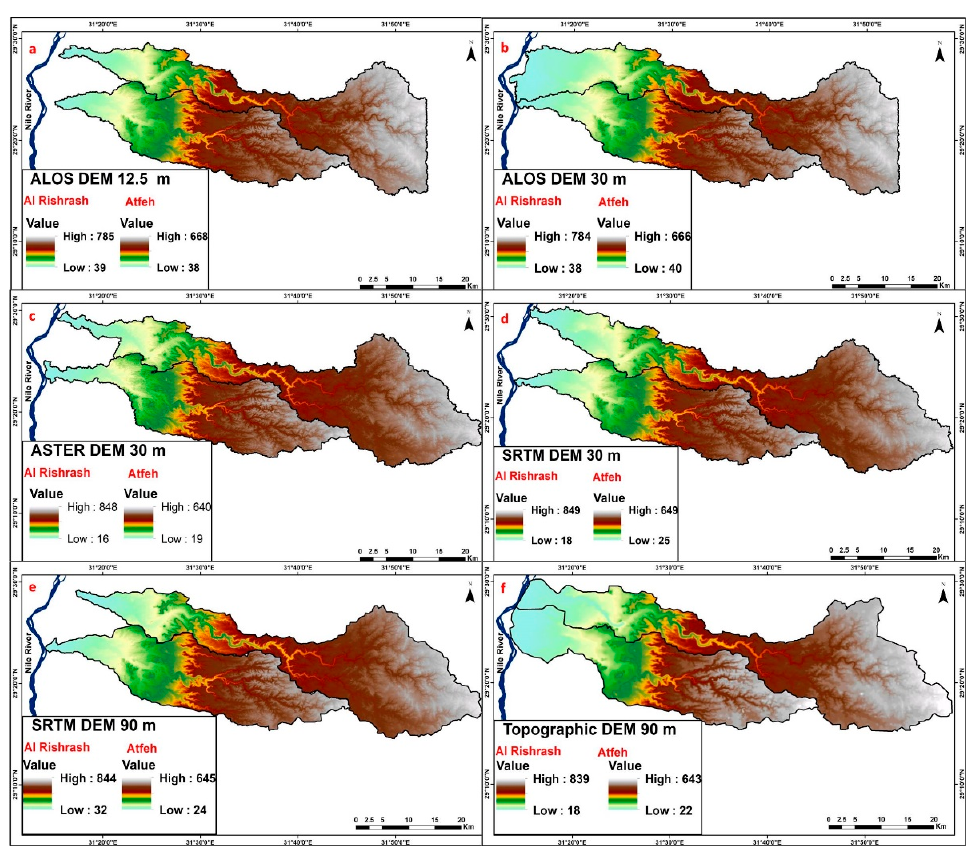
Figure 4. Examples of different DEMs sources used in hydrological analysis of Wadi Al Rishrash and Wadi Atfeh catchments including ( a ): ALOS DEM (12.5 m resolution), ( b ): ALOS DEM (30 m resolution), ( c ): ASTER DEM (30 m resolution), ( d ): SRTM DEM (30 m resolution), ( e ): SRTM DEM (90 m resolution) and ( f ): topographic map-derived DEM (90 m resolution).